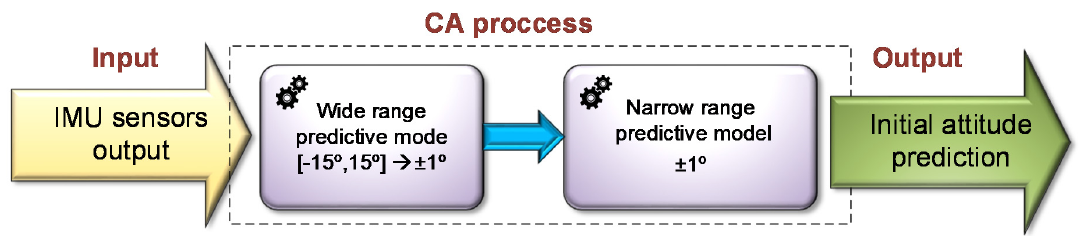
Figure 4. Proposed MLCA pyramidal process- wide range followed by narrow range regression.